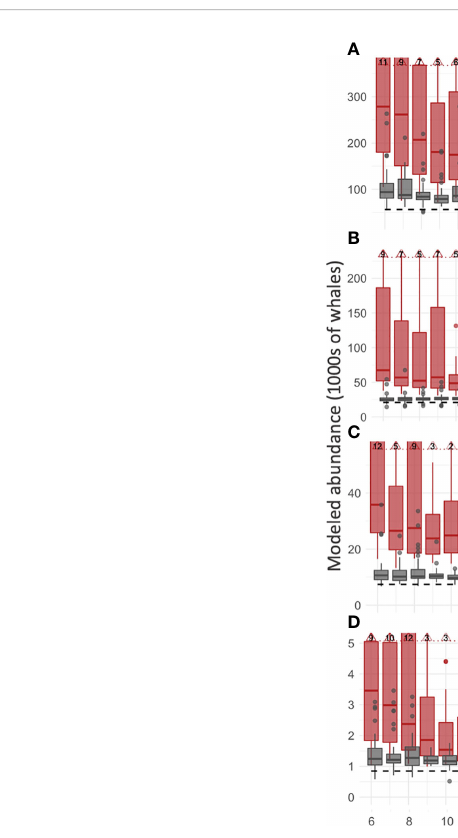
FIGURE 4 Resampling to detect improvement in precision and accuracy of abundance estimates. The relationship between sample size (number of voyages, x-axis) and improvements in accuracy (modeled abundance, grey boxplots, left y-axis) and precision (CV, red boxplots, right y-axis) are plotted for each of the four simulated whale fi elds ( A-D , humpback, fi n, minke, blue respectively). Median values are horizontal lines on boxplots. The upper bound on a useful CV value (0.25, dashed red line) and true simulated whale abundance (dashed black line) are plotted. Light grey boxes mark the sample size, before which CV improves substantially with increased sample size and after which there is negligible improvement in CV. Note these plots are zoomed to exclude some CV values (large red triangles), and the number of values not plotted is noted (black text inside large red